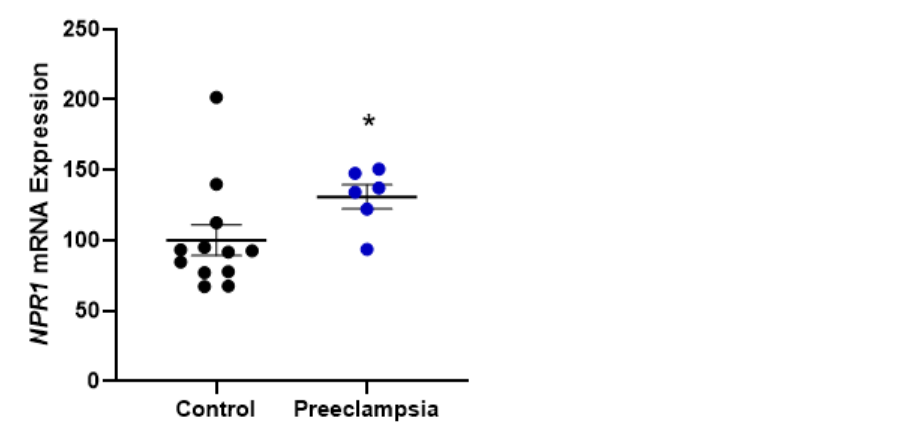
Figure 3. Omental artery expression of ANP receptor NPR1 significantly increased with preeclampsia. Omental artery expression of NPR1 is significantly increased in cases of preterm preeclampsia (<34 weeks gestation) compared to normotensive controls. Data are mean ± SEM, n = 6–12, * p < 0.05.